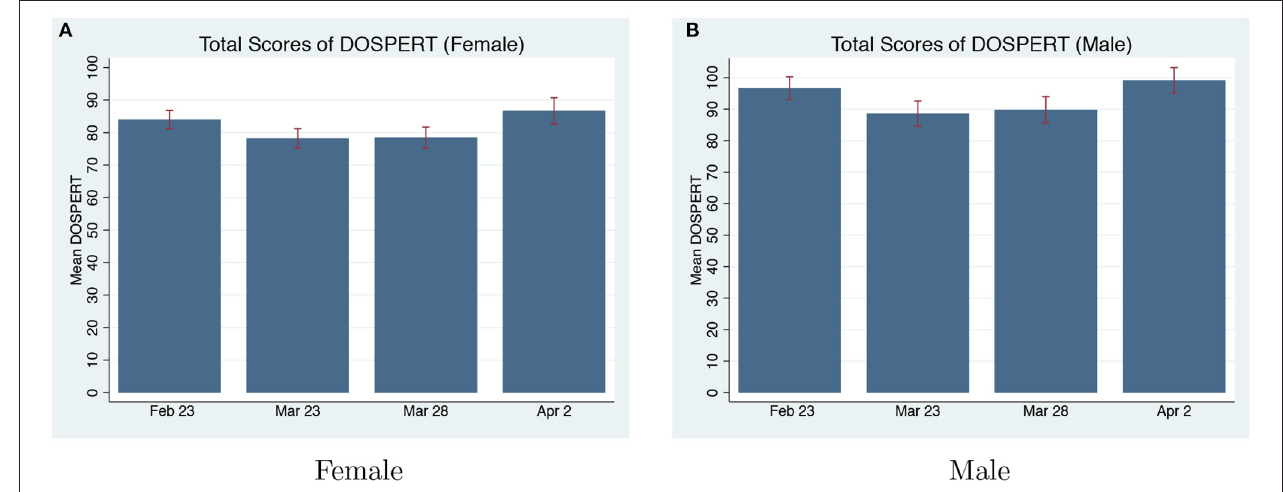
FIGURE 4 | DOSPERT-Total Scores Pre and On-Pandemic. (A) Total scores of DOSPERT (Female). (B) Total scores of DOSPERT